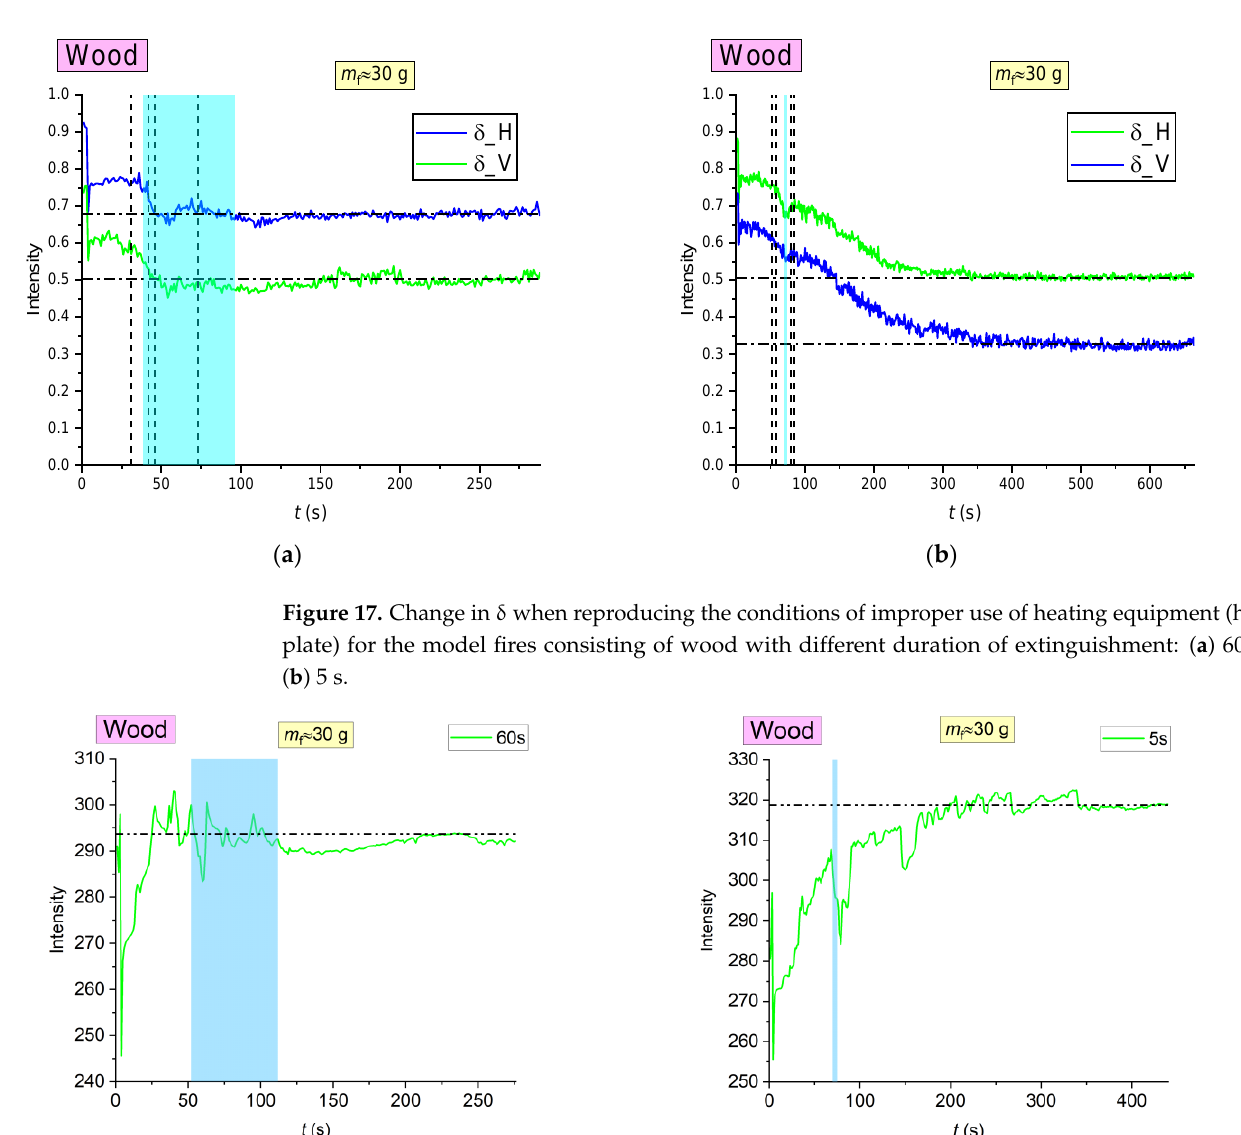
Figure 18. Change in the absolute average intensity of images when reproducing the conditions of improper use of heating equipment (hot plate) for the fires involving wood with different duration of extinguishment: ( a ) 60 s; ( b ) 5 s.